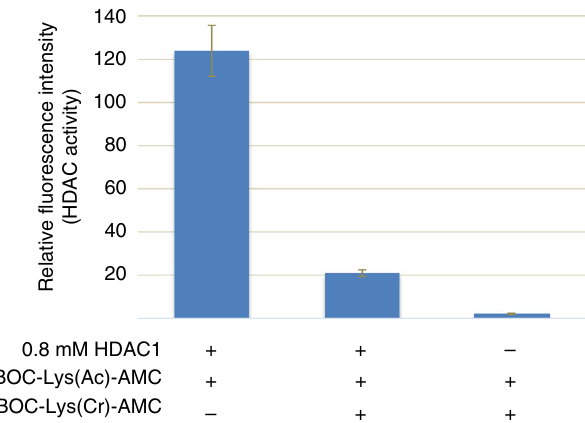
Fig. 8 BOC-Lys(crotonyl)-AMC inhibits deacetylation by HDAC1. A fl uorometric in vitro assay showing that HDAC1 ef fi ciently deacetylates the BOC-Lys(acetyl)-AMC substrate alone, but not in the presence of same amounts of BOC-Lys(crotonyl)-AMC. Performed in triplicate, error bars are standard and colon versus small intestine fraction have been calculated with a two-way ANOVA test using the Perseus software 49 . p -Value < 0.01 (1% FDR) were con- sidered as signi fi cant.